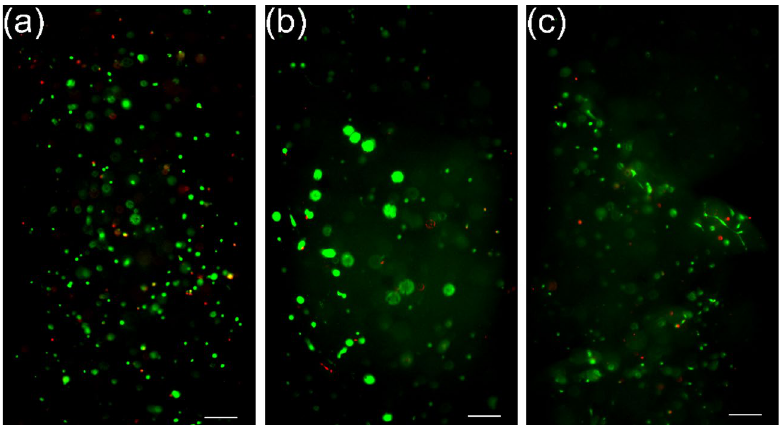
Figure 6. Fluorescence OPT projection images of live (green) and dead (red) fibroblasts cultured for 7 days in 3D ( a ) GG, ( b ) gelatin-GG, and ( c ) Geltrex hydrogels. The scale bar in the images represents 200